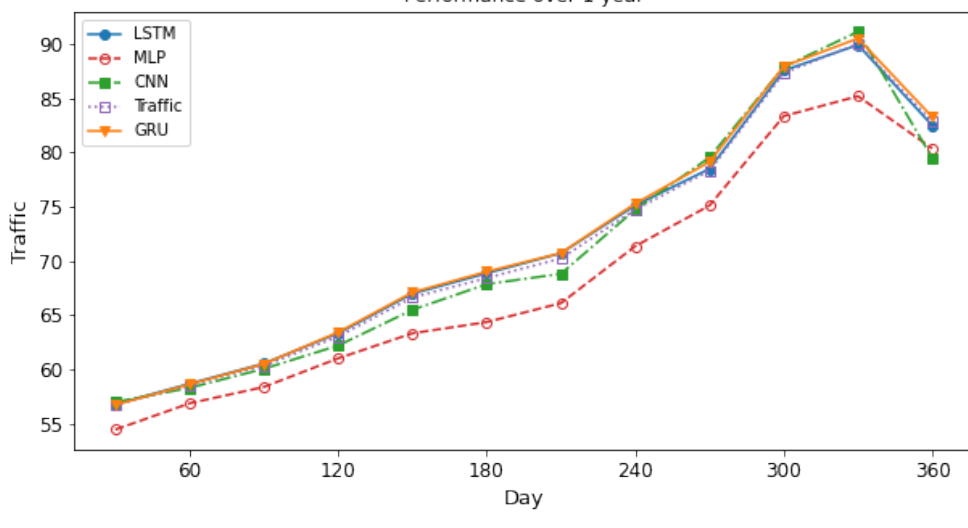
Figure 8. Different DL models performance